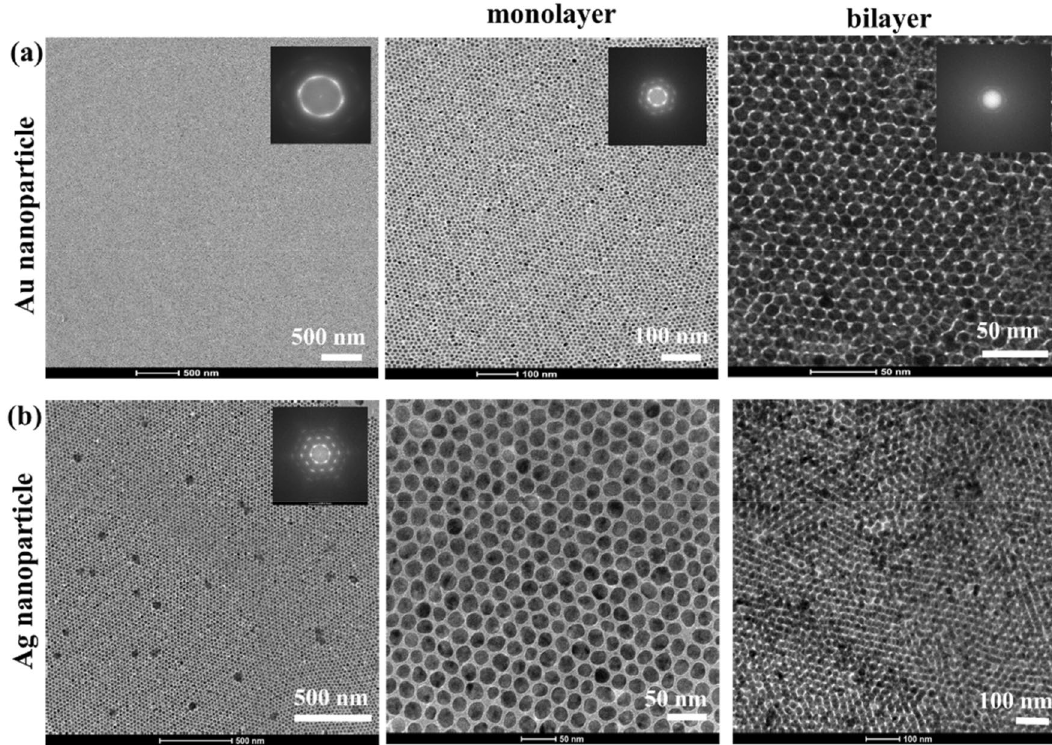
Figure 2. ( a ) TEM images of Au ( a ) and Ag ( b ) nanoparticle self-assemblies at different length